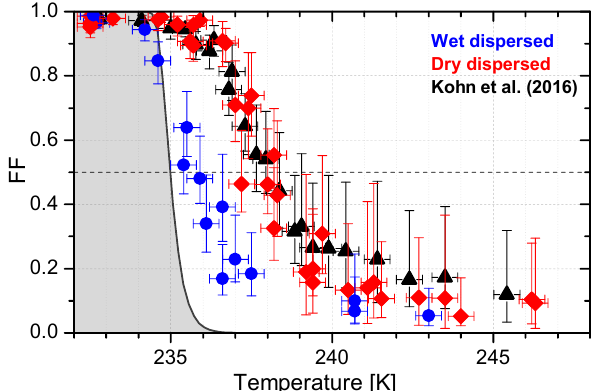
Figure C1. Frozen fraction for measurements of size-selected kaoli- nite (Fluka) particles (400nm) using the PIMCA-PINC instrument after the LINC campaign (blue and red). Data from a previous study by Kohn et al. (2016) are shown for comparison (black; dry dis- persed).